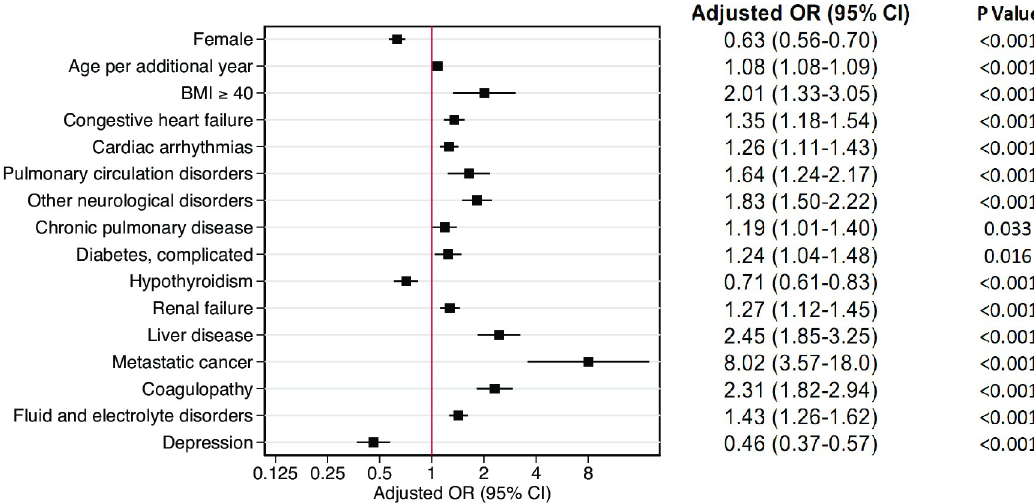
Fig 4. Multivariable logistic regression analysis for 180-day all-cause mortality after hospital admission. CI confidence interval, OR odds ratio, BMI body mass index. Only significant risk factors are included in the model. Each covariate has been adjusted for all other covariates displayed.